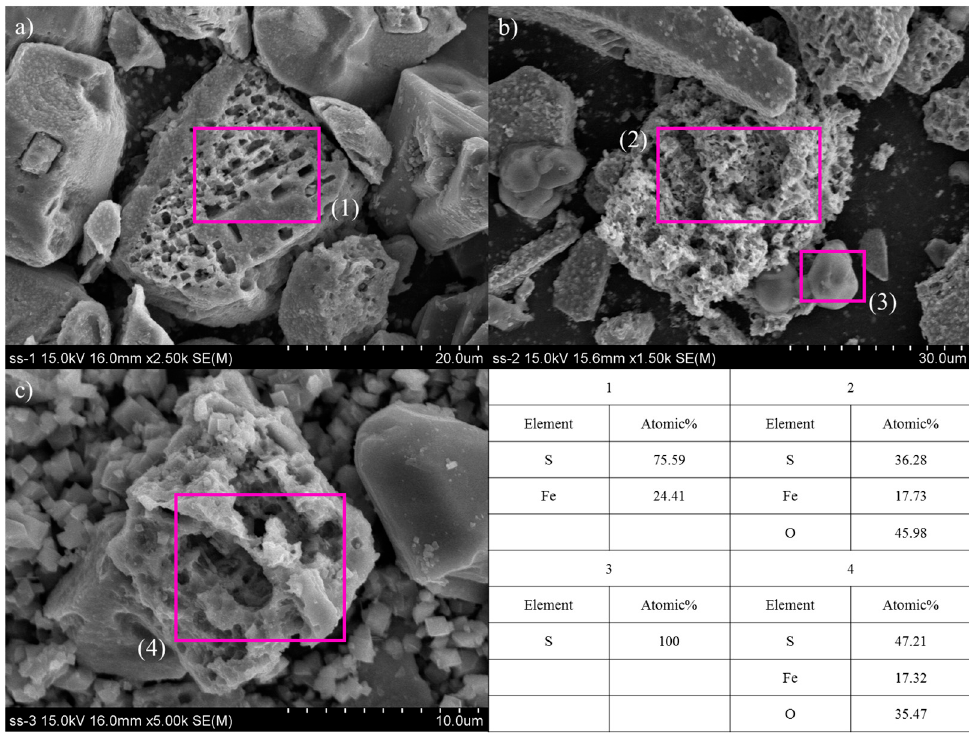
Figure 15. XRD patterns of raw and leach residue from nitric acid leaching at 1.0, 3.0 and 5.0 M. The leaching time was 15 min.